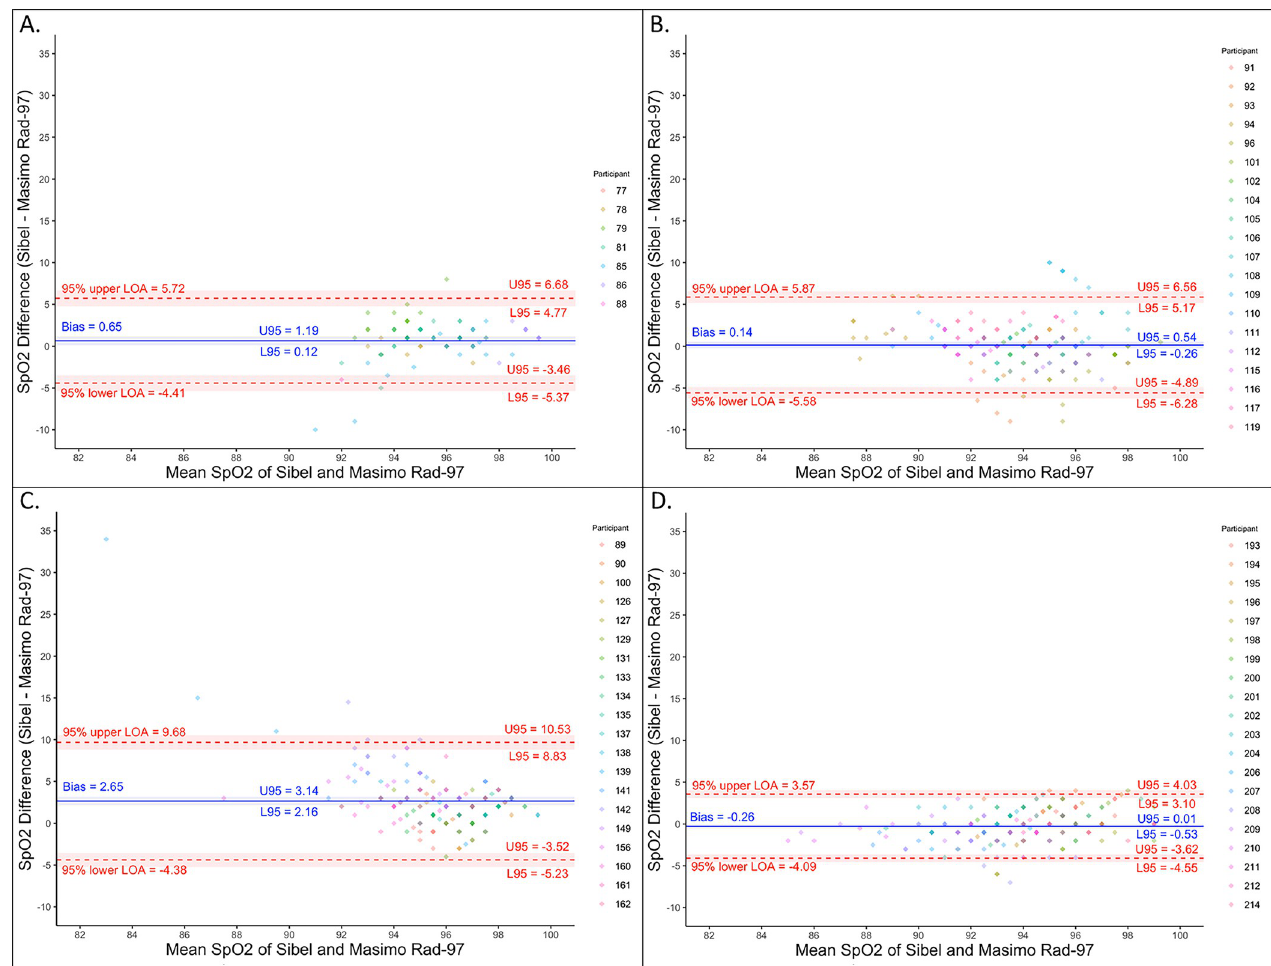
Fig 4. Bland-Altman plots for oxygen saturation (SpO 2 ). (A) Open-label round. (B) Closed-label round one.(C) Closed-label round two. (D) Closed-label round three. Colors indicate which enrolled neonate is associated with the measurement